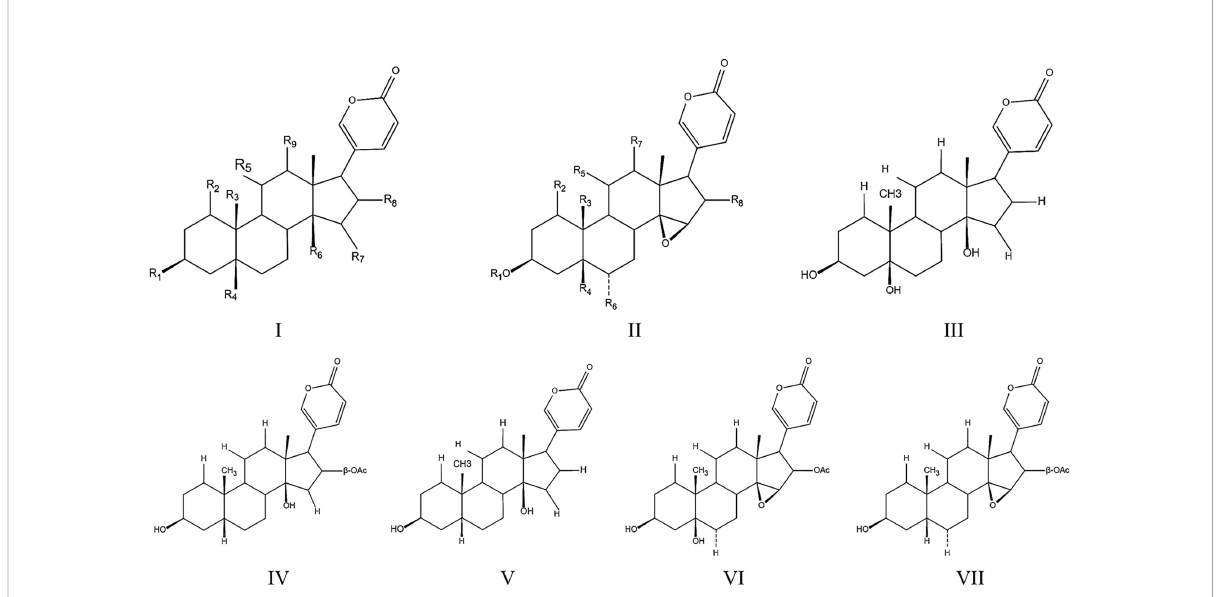
FIGURE 1 Toadienohydroxylate lactone parent nucleus (I, II), Telocinobufagin (III), Bufotalin (IV), Bufalin (V), Cinobufotalin (VI), Cinobufagin